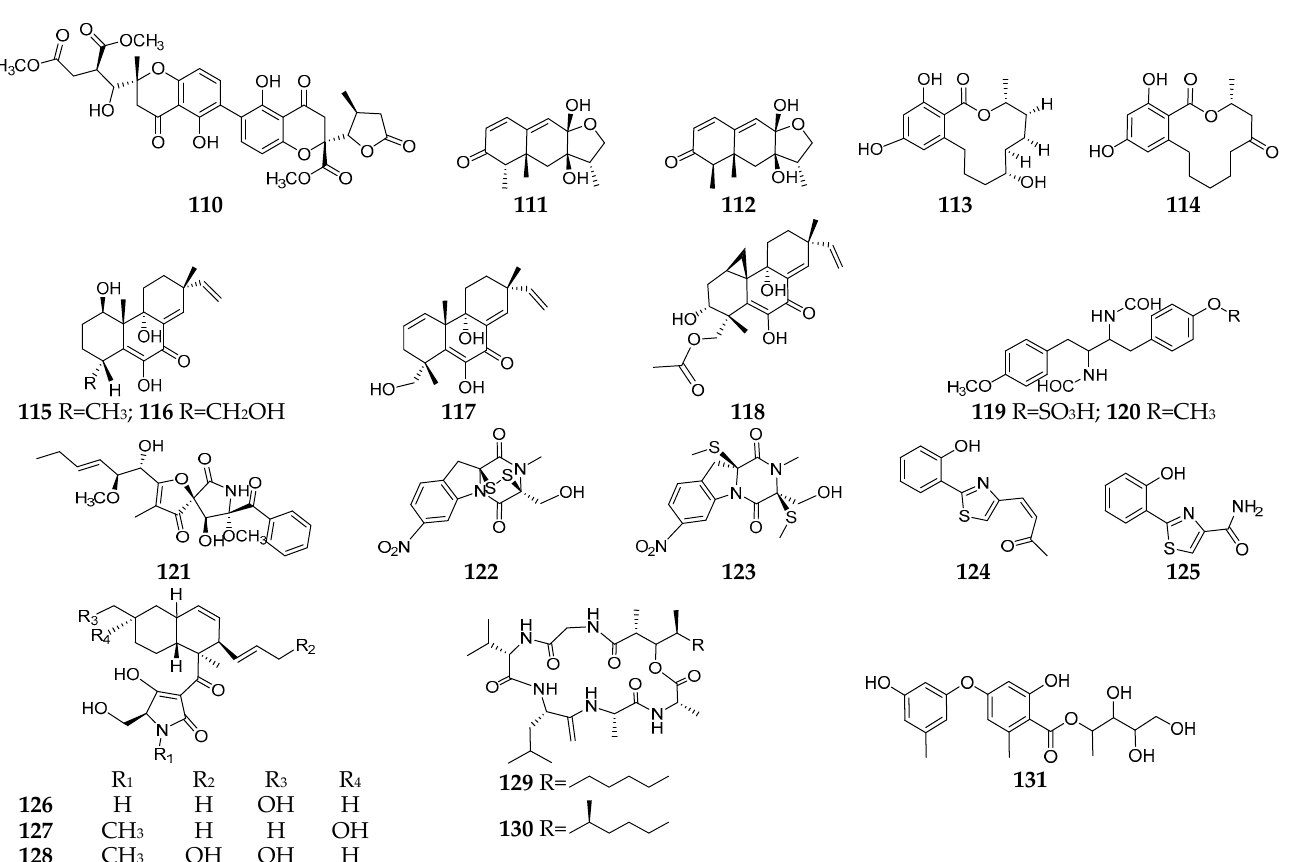
Figure 7. New SMs ( 110 – 131 ) isolated from fungal–bacterial co-culture using LSF.